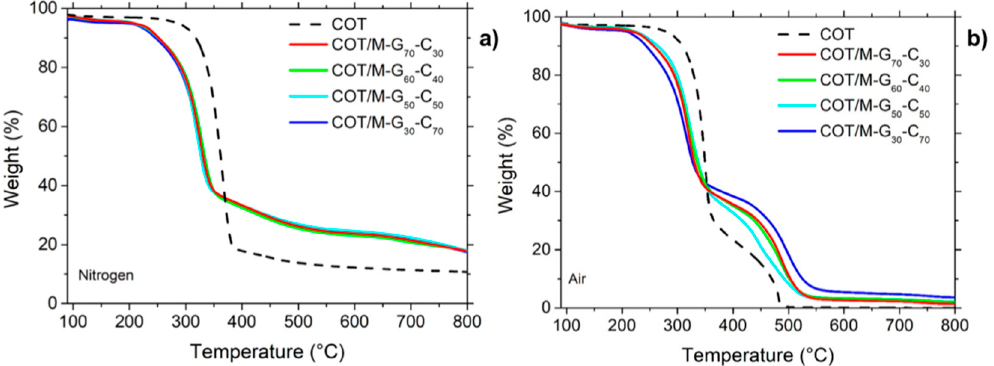
Figure 3. TG thermograms of PAA-treated cotton fabrics in nitrogen ( a ) and air ( b ). Add-ons: 16.0 ± 0.5%. Table 4. Thermal data of PAA-treated cotton fabrics in nitrogen and air by thermogravimetric analysis.